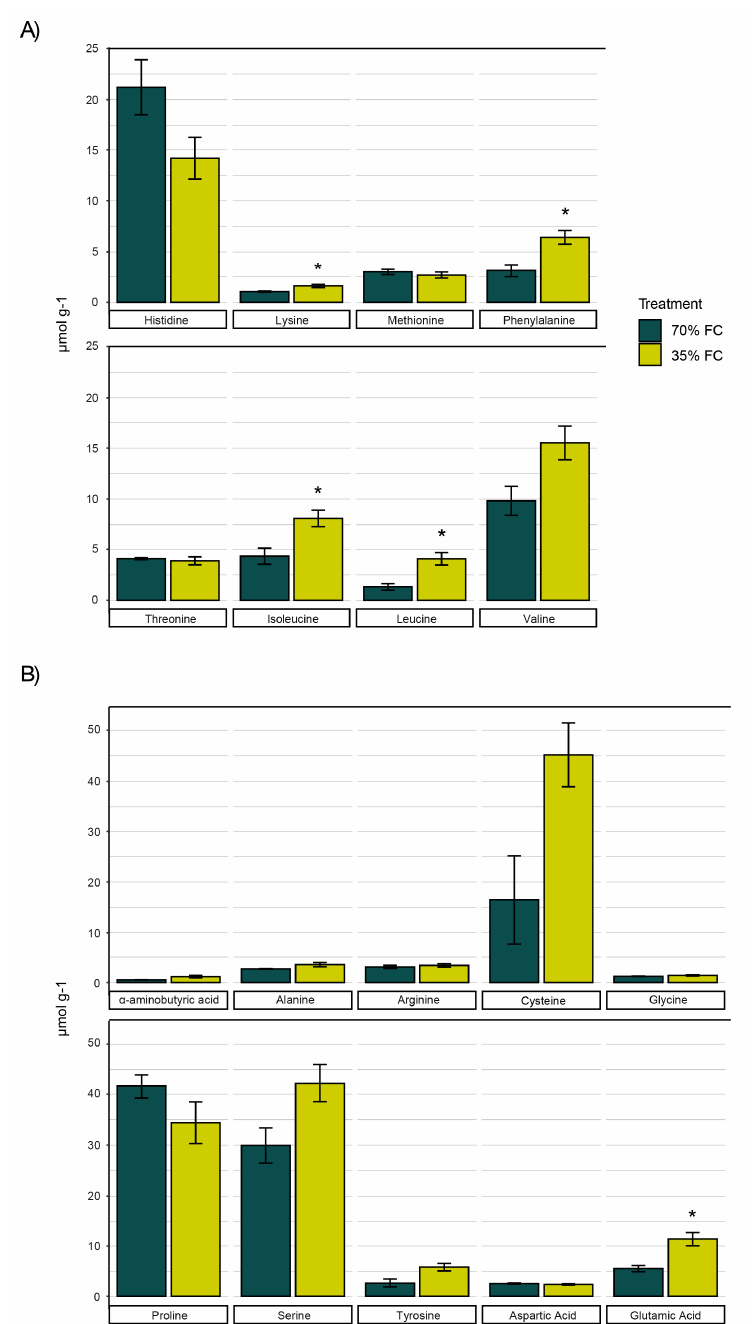
Figure 2. Concentrations of essential ( A ) and non-essential ( B ) amino acids in potato tubers ( n = 4) sampled during the tuber bulking phase and the associated SEM ( p < 0.05) when subjected to 70% and 35% field capacity. * significance ( p < 0.05) between 35% field capacity.